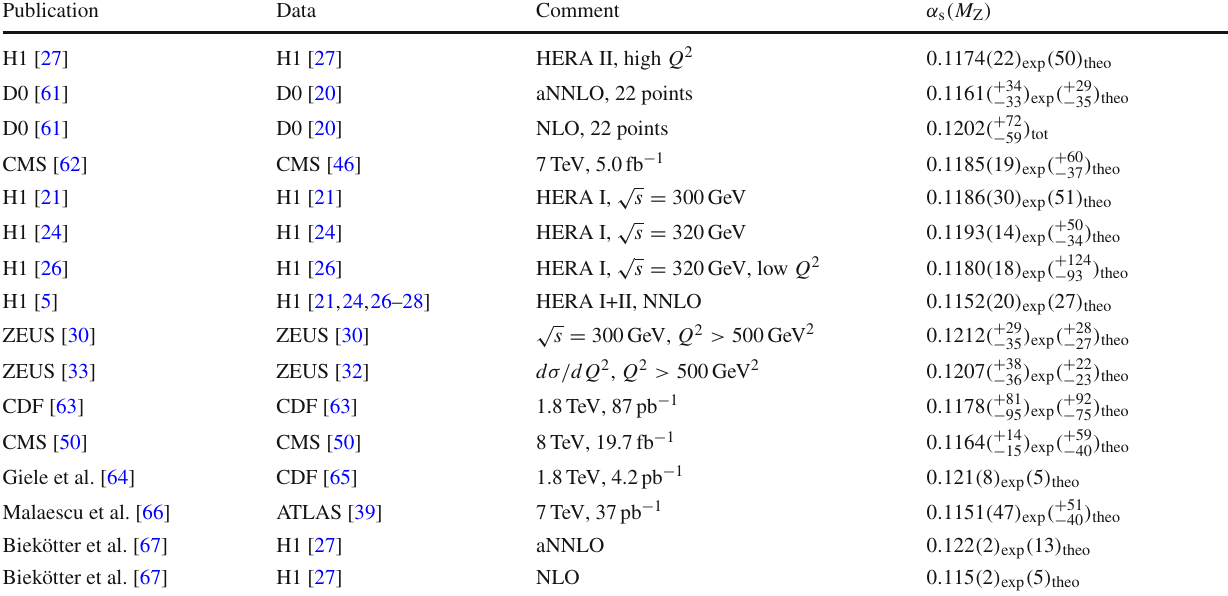
Table 1 Summary of previous determinations of α s ( M Z ) from inclu- sive jet cross sections. Rows 1–4 list the recent α s ( M Z ) extractions from double-differential inclusive jet cross sections by experimental collab- orations that are studied in more detail in this work. Rows 5–12 and 13–16 summarise further determinations of α s ( M Z ) by experimental collaborations and by independent authors, respectively. The results in Refs. [61,67] are reported for approximate NNLO (aNNLO) and NLO